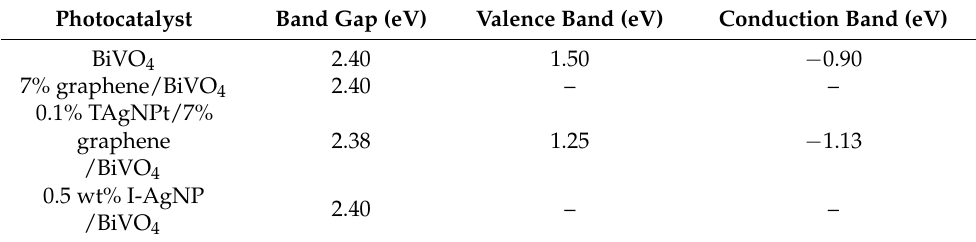
Figure 4. EDS spectrum of 0.003% TAgNPt/7% graphene/BiVO 4 . Table 2. Band gap calculation of the obtained photocatalysts.